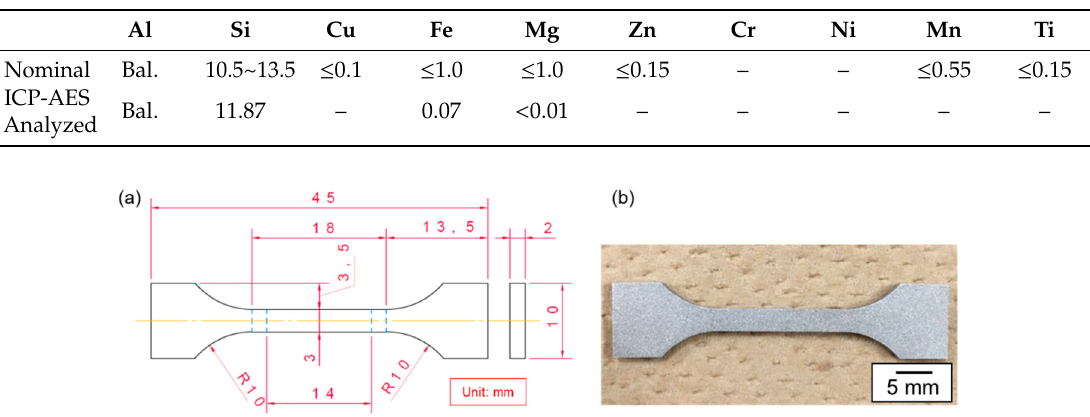
Figure 1. ( a ) Dimension of the tensile test specimen and ( b ) a photograph showing the appearance of the tensile test specimen used in the present study. Table 1. The chemical composition of the LPBF-fabricated Al–12%Si alloy sample (mass%) analyzed by using inductively coupled plasma atomic emission spectrometry (ICP-AES).